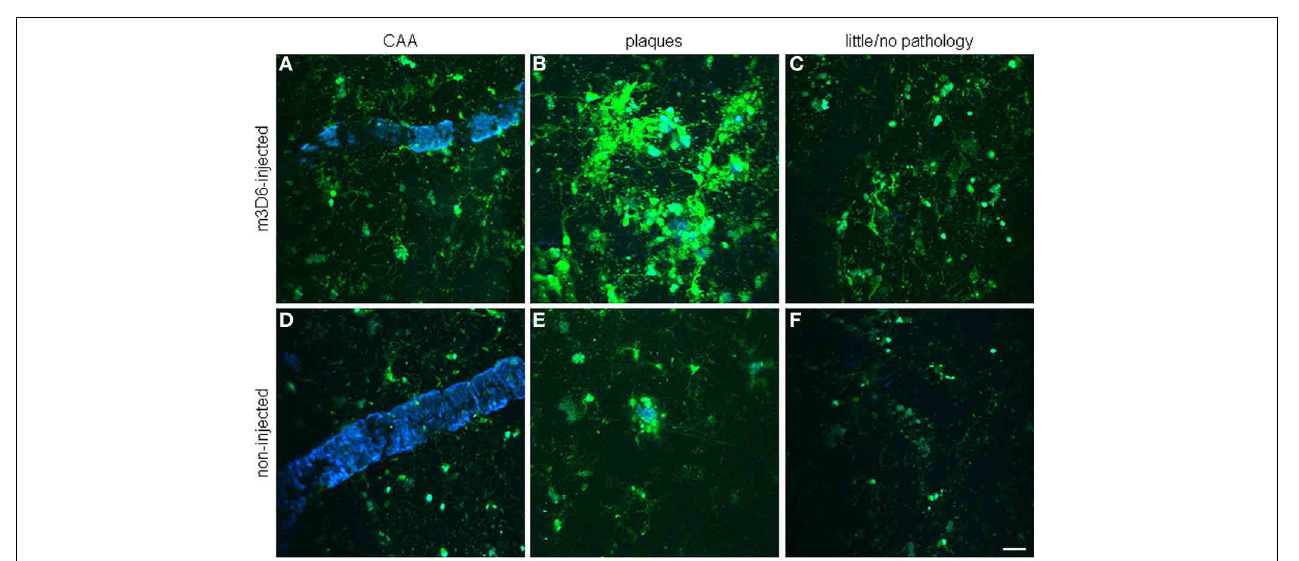
vessels for each individual mouse are highlighted. Average tortuosity of penetrating vessels for each sample subject (mean ± standard error): wild-type mice 1.03 ± 0.003, transgenic TgCRND8 mice 1 . 10 ± 0 . 006, scyllo -inositol-treated TgCRND8 mice 1.03 ± 0.005. Reproduced with permission from Dorr et al. (2012), © 2012 the authors.